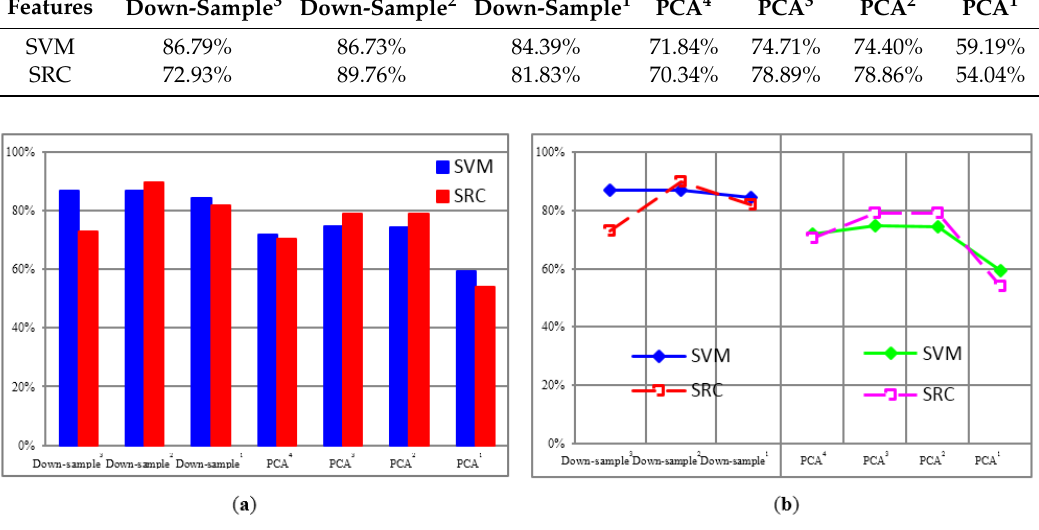
Figure 5. The recognition rates under different unconventional feature spaces; ( a , b ) are two forms of the recognition rates. Down-sample 3 refers to reducing the dimensions of the cropped image to a size of 1600 by down-sample. Similarly, Down-sample 2 , Down-sample 1 , PCA 4 , PCA 3 , PCA 2 and PCA 1 stand for sizes of 400, 100, 400, 125, 100 and 25, respectively.